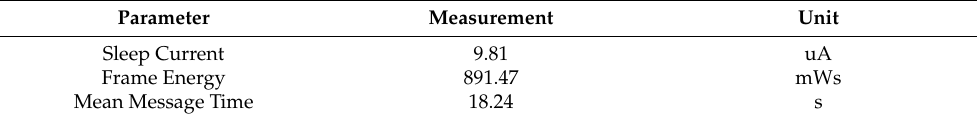
Table 2. Numerical results from power analysis of the